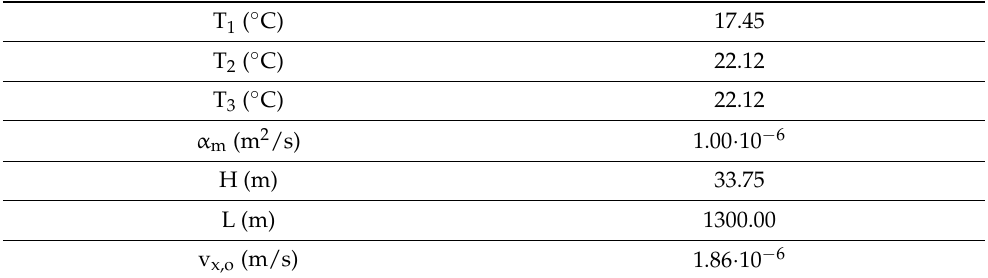
Figure 11. Application of step 2 of the inverse problem protocol. Triangles for dimensionless temperatures in well 1 (x 1 ) and points for dimensionless temperatures in well 2 (x 2 ). Table 4. Input data for direct problem.